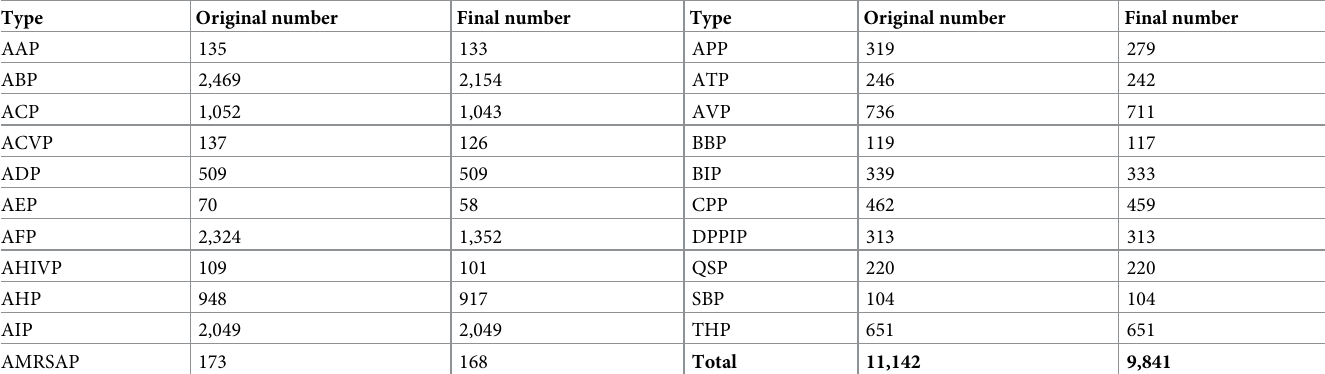
Table 1. The summary of the dataset used in this work.